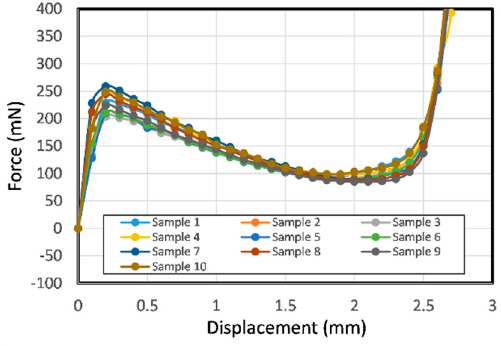
Figure 12. Experimental force–displacement relationship for ten molded samples of single V-beam structure.